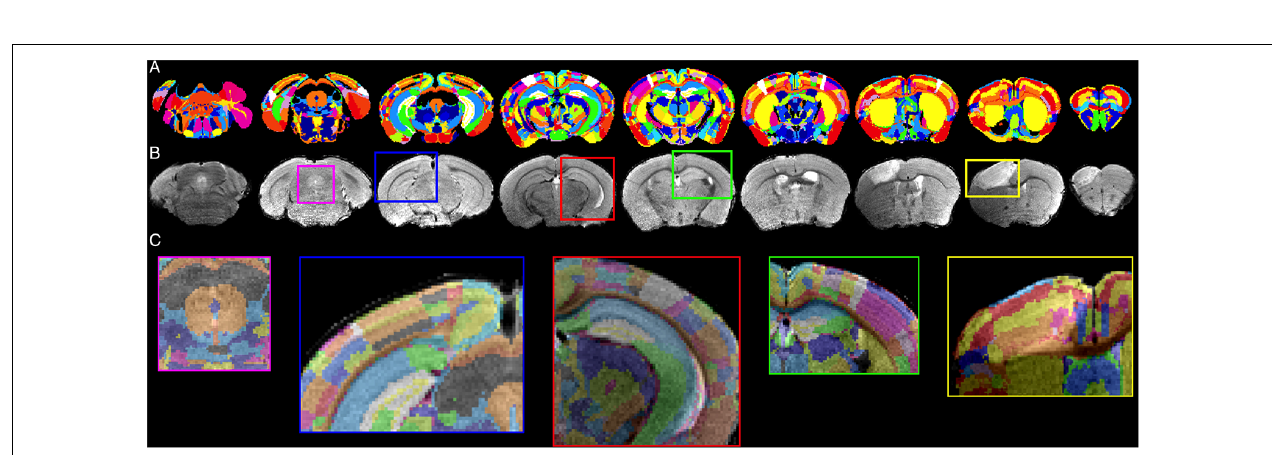
FIGURE 6 | Registration results. Representative transformed ARA annotations (A) that are registered on an T2w data set (B) with detailed views shown as overlay (C) .